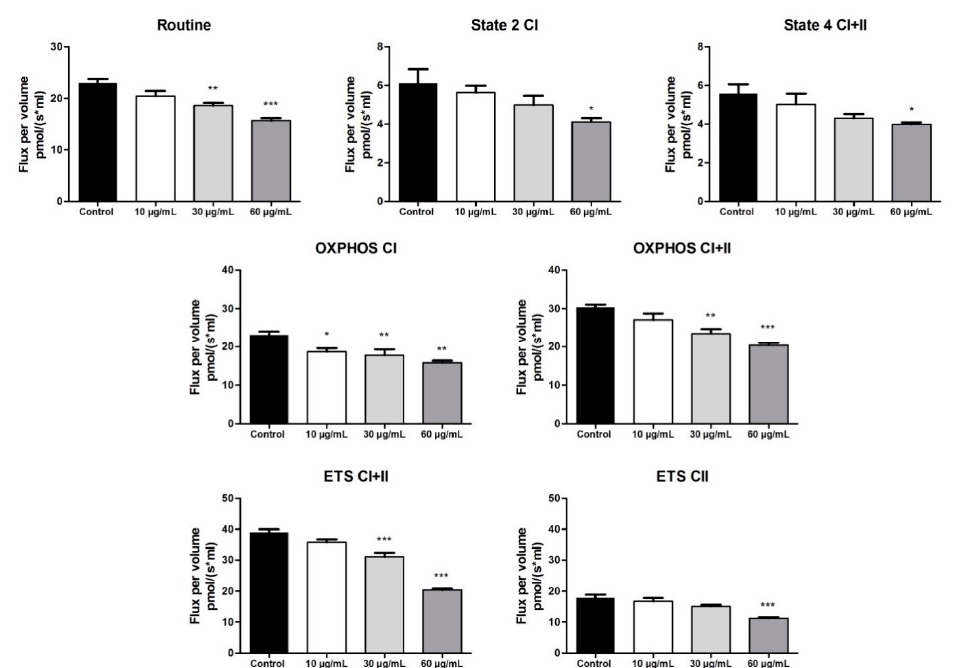
Figure 5. OB extract (10, 30, 60 µg/mL) effects on A375 human melanoma cells on mitochondrial respiratory rates at 72 h post-stimulation. Data are expressed as mean ± SD of four independent experiments. (* p < 0.05; ** p < 0.01; *** p < 0.001 vs. control calculated by one-way ANOVA, followed by a Tukey post-test). (CI: complex I; CII: complex 2; OXPHOS: oxidative phosphorylation; ETS: electron transfer system).